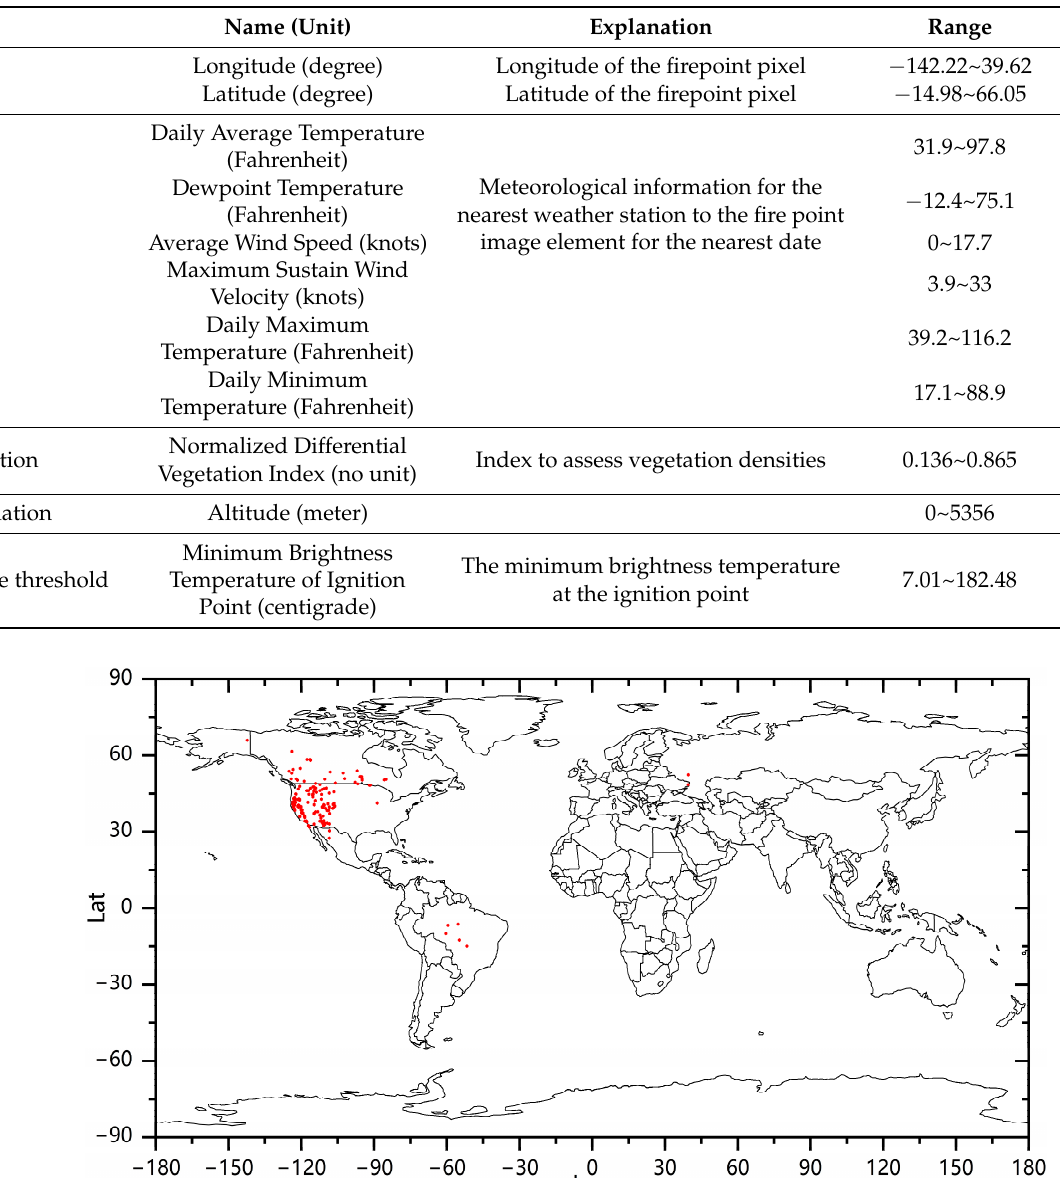
Table 1. Detailed explanation of the characteristics of the MODIS_DT_Fire dataset.